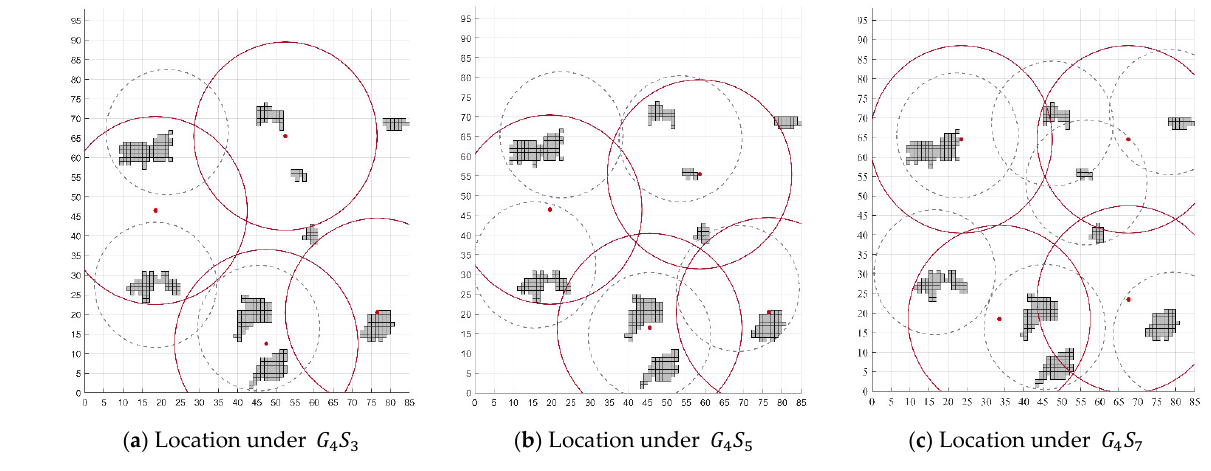
Figure 10. Layout fluctuations in terms of .